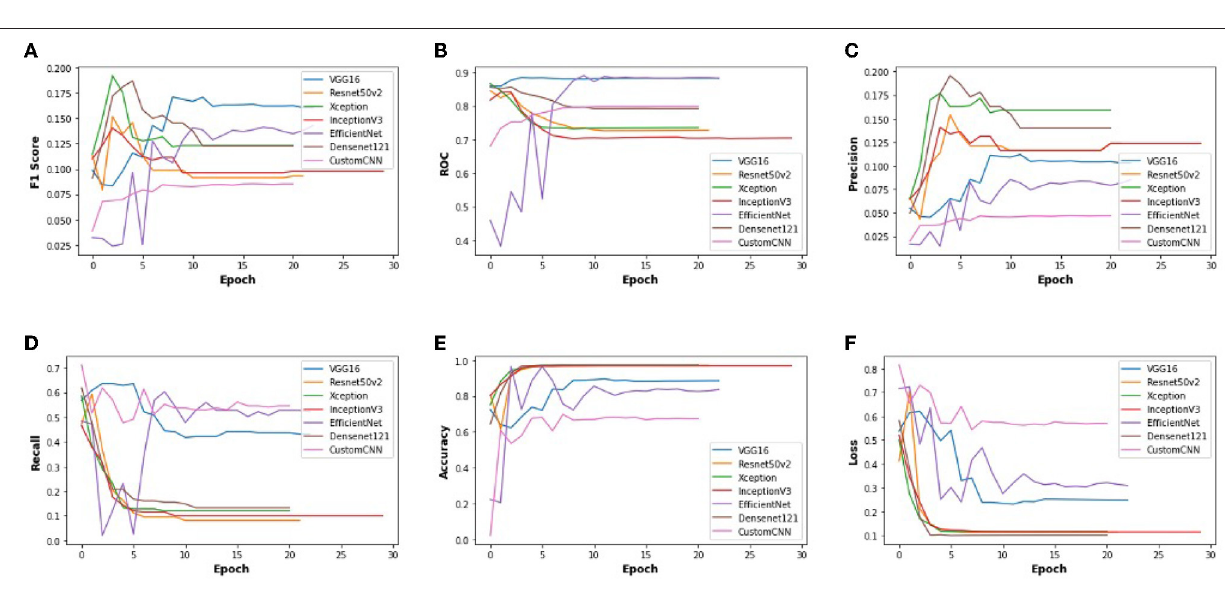
Frontiers in Big Data |